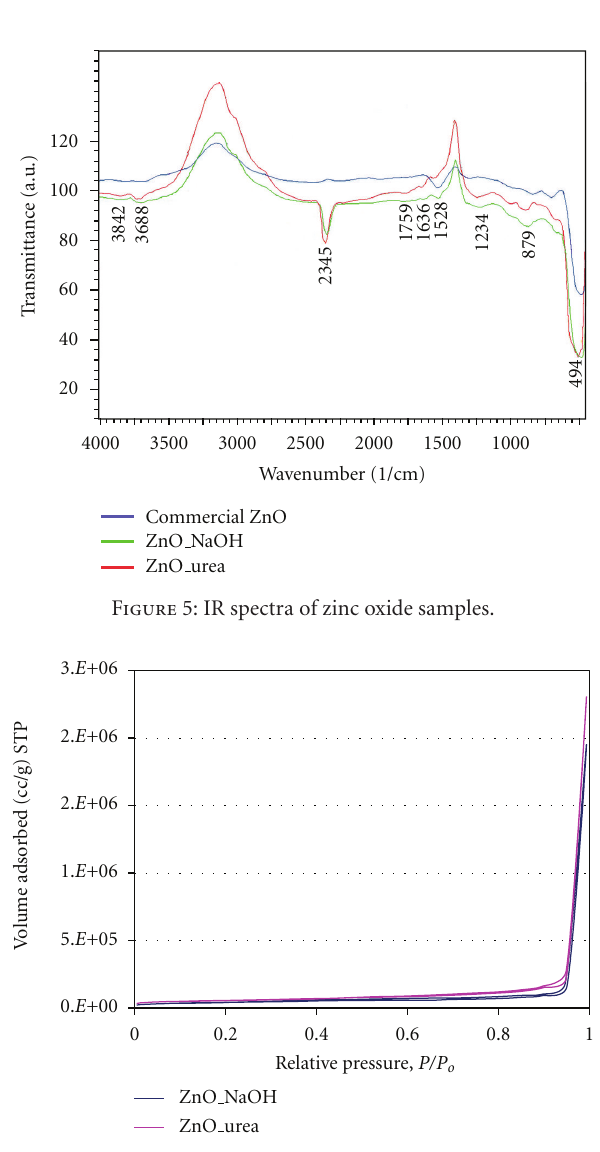
Figure 6: BET analysis results for ZnO.